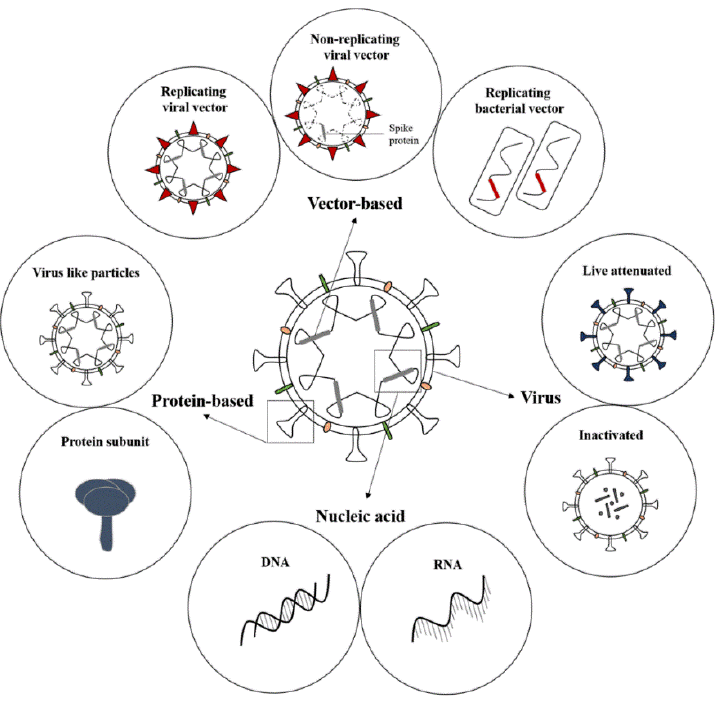
Figure 1. SARS-CoV-2 vaccine types. SARS-CoV-2 vaccines currently in pre-clinical and clinical evaluation make use of various platforms (image created by Juanita Mellet).